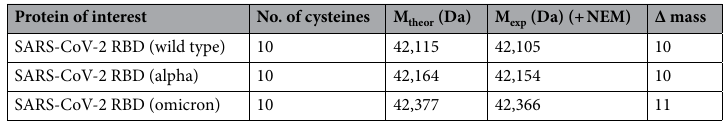
Table 1. Molecular weight analysis of purified SARS-CoV-2 RBD wild type and variants by electrospray ionization mass spectrometry (ESI–MS) under NEM treated conditions. Formation of one disulfide bond accounts for a mass difference of 2 Da in the experimental molecular weight (M exp ) from the theoretical molecular weight (M theor ). No NEM binding (+ 125 Da) was observed for any of the samples analyzed suggesting the absence of free thiols.